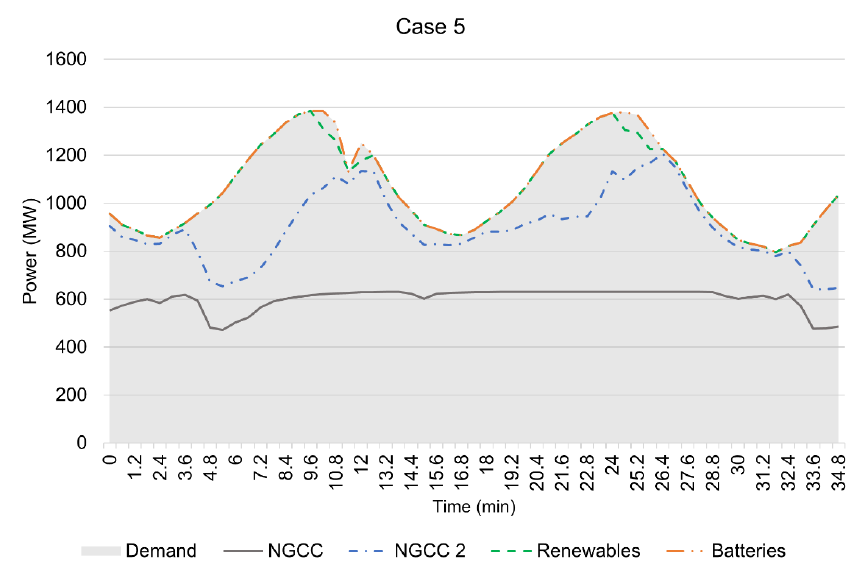
Figure 19. Power dispatch optimization result for Case 5.